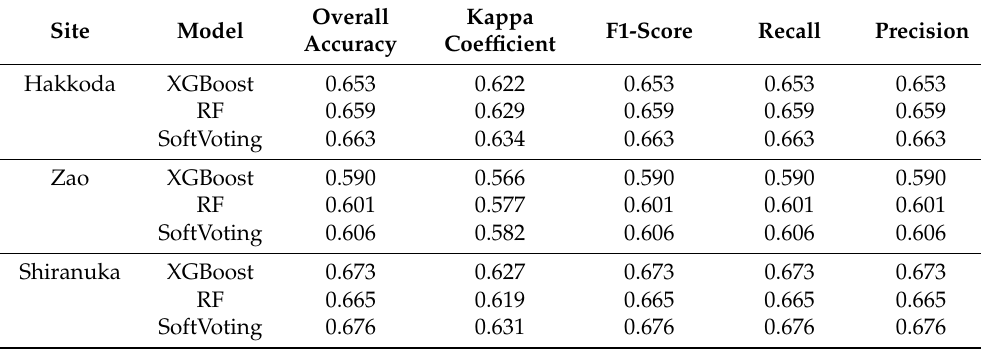
Table 3. Performance of the very high-resolution suite using single-date autumn